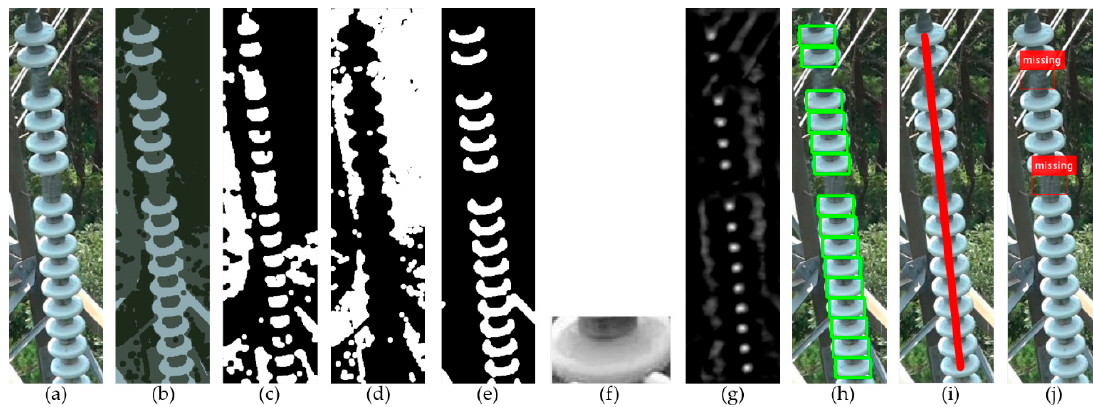
Figure 6. Steps of the broken shed detection. ( a ) Detected insulator image from CNN-based detector, ( b ) output of color clustering based segmentation, ( c – e ) segmentation masks of the three clusters, ( f ) candidate template after connected component analysis and max voting to find the most repeating pattern, (g ) response map of the template matching, ( h ) results of template matching, ( i ) fitting the centers of the template matching result to a straight line, ( j ) final detected defect.